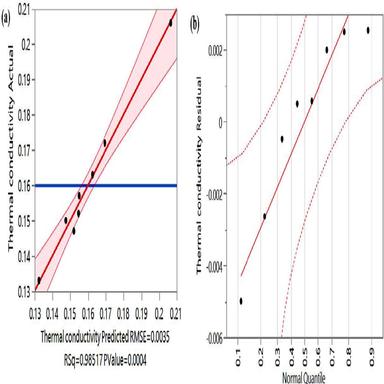
Plots for residual vs predicted and residual normal quantile.